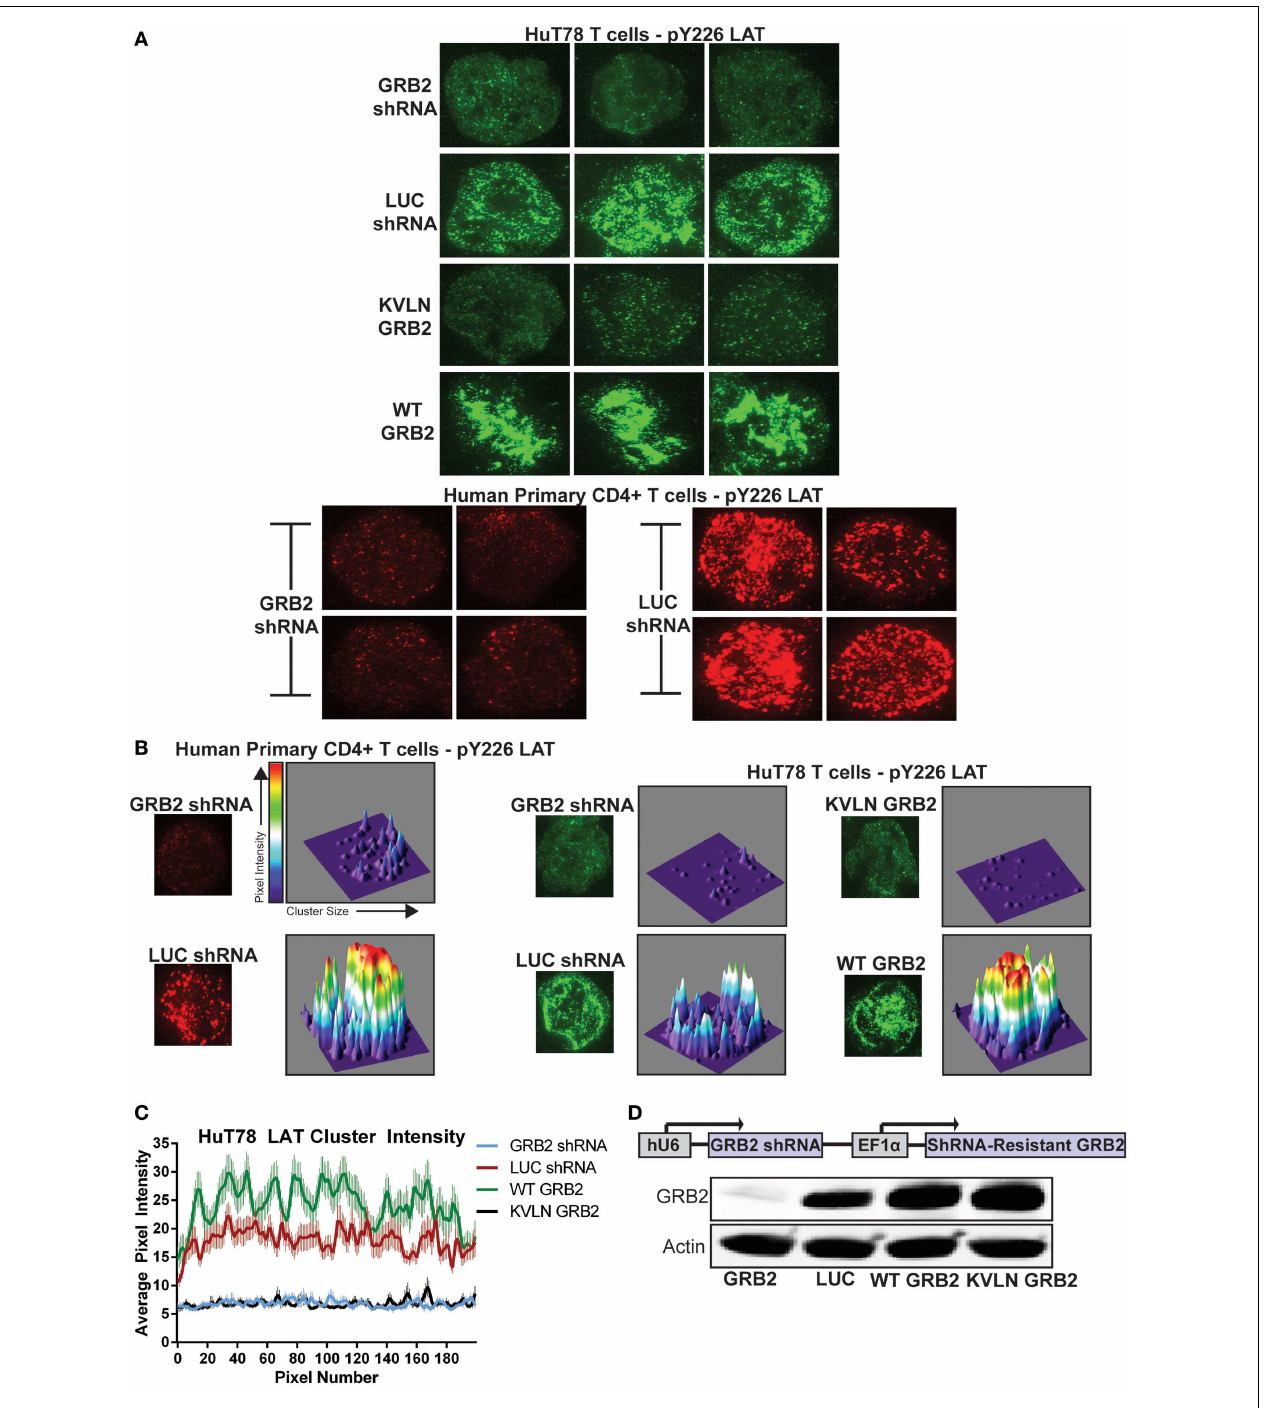
intensities of clusters across the axis ofT cells containing GRB2 shRNA ( n = 65), LUC shRNA ( n = 60), wild-type GRB2 ( n = 60), KVLN ( n = 60) were quantified using ImageJ’s “Plot Profile” function. (D) Top: schematic diagram of GRB2 knockdown and shRNA-resistant protein reconstitution. Bottom:The expression of GRB2 in HuT78T cells transduced with lentiviral constructs carrying LUC and GRB2 shRNA with or without re-expression of shRNA-resistant GRB2